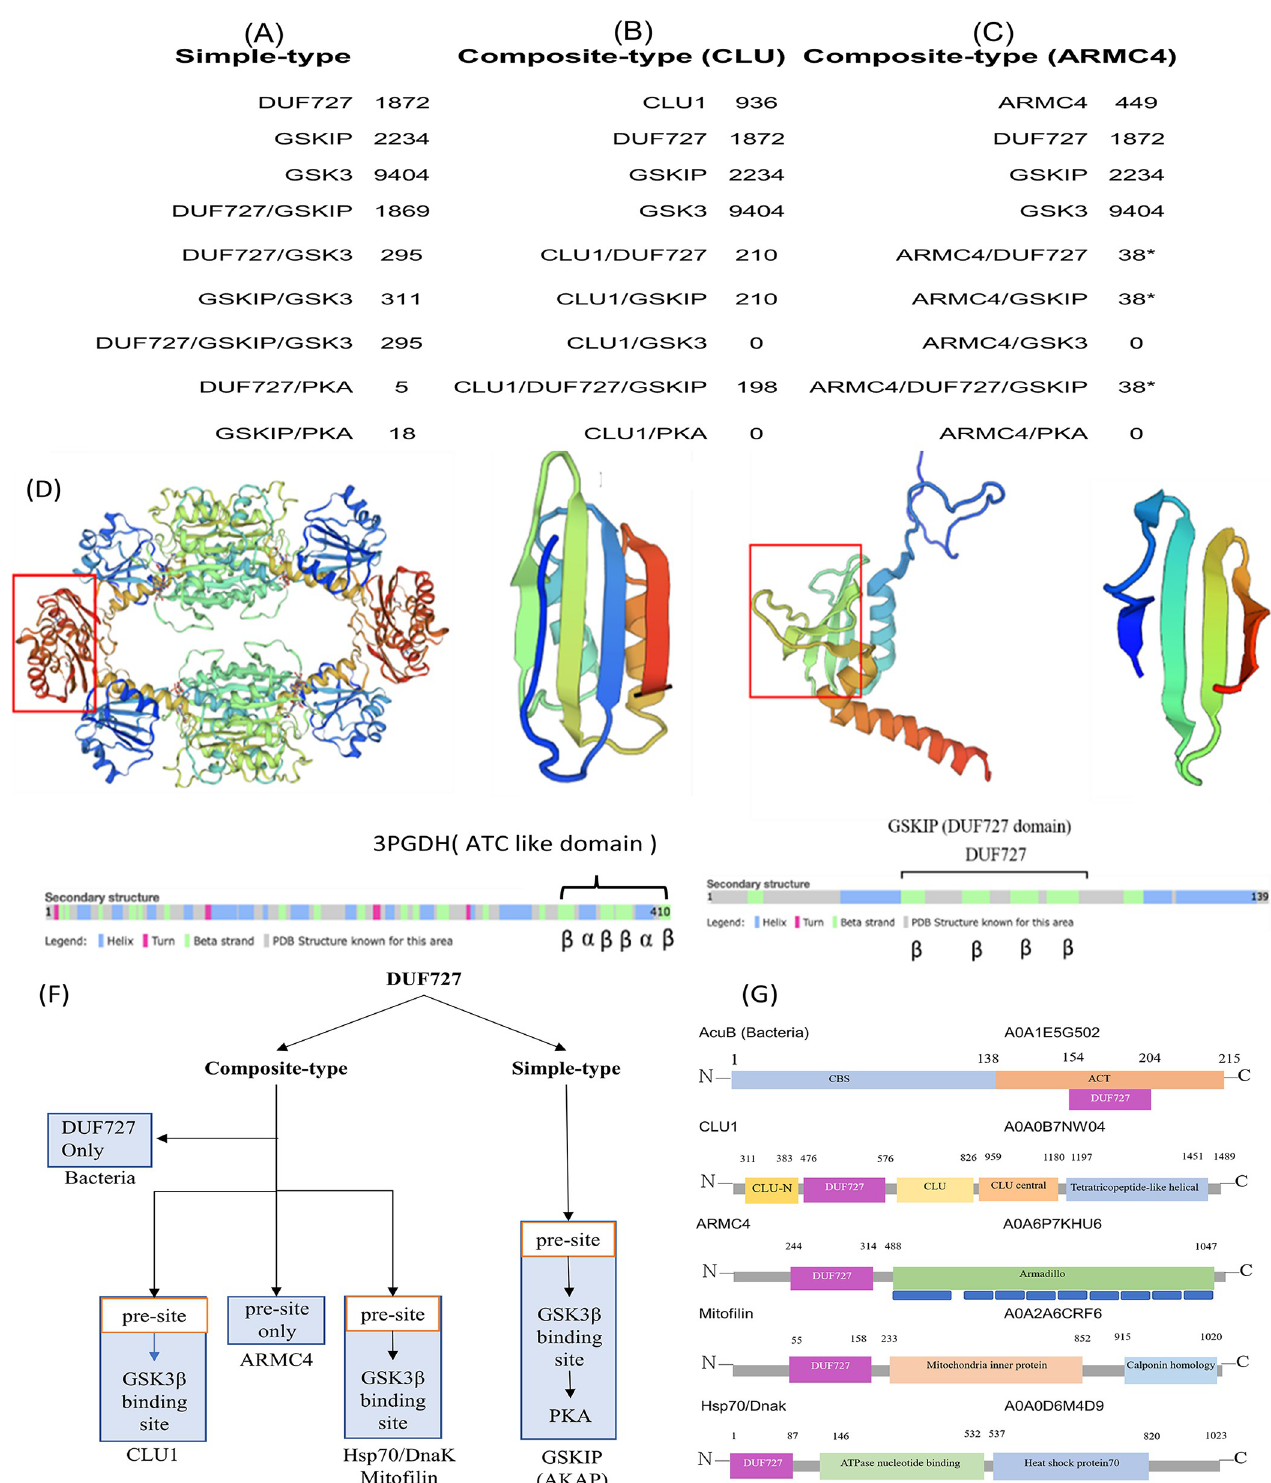
Fig 1. Summary of UniProt and InterPro data mining to reveal two types of GSKIP. A, Evolved simple-type GSKIP from DUF727 to pre-GSK3 β and then evolution to the GSK3 β -binding site. The results of UniProtKB data retrieval using keywords are provided. When using GSKIP as a keyword, a total of 2234 protein entries were found, but the records were reduced when other terms such as DUF727, GSK3 β , and PKA were added. B, When using CLU1 as a keyword, 936 protein entries were found, and 210 protein entries were convergent with the keywords “DUF727” or “GSKIP.” C, Using ARMC4 as a keyword resulted in